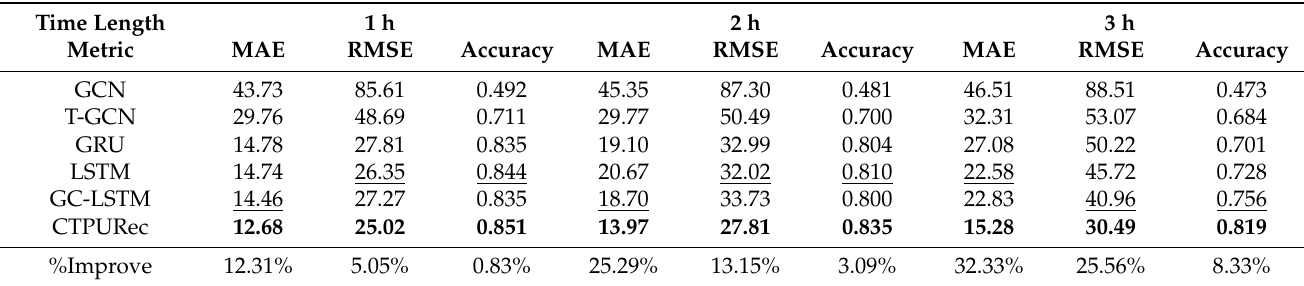
Table 1. Prediction errors at different time lengths. The best performing method in each row is boldfaced, and the second-best method in each row is